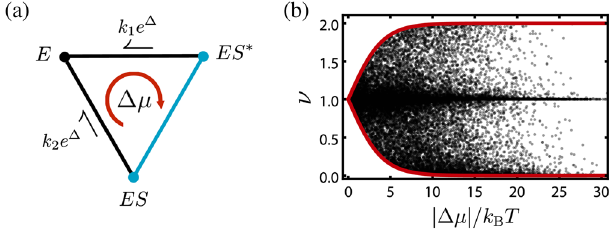
FIG. 5. Bounding the discriminatory index. (a) Graph of a single-cycle kinetic proofreading network. Perturbations in the (dimensionless) binding energy Δ can be unraveled as blue vertex and edge perturbations. (b) Discriminatory index ν plotted against the thermodynamic affinity j Δ μ j =k B T for the single-cycle net- work generated from 30 000 randomly sampled transition rates. All samples fall within the predicted bound (26) (red line).